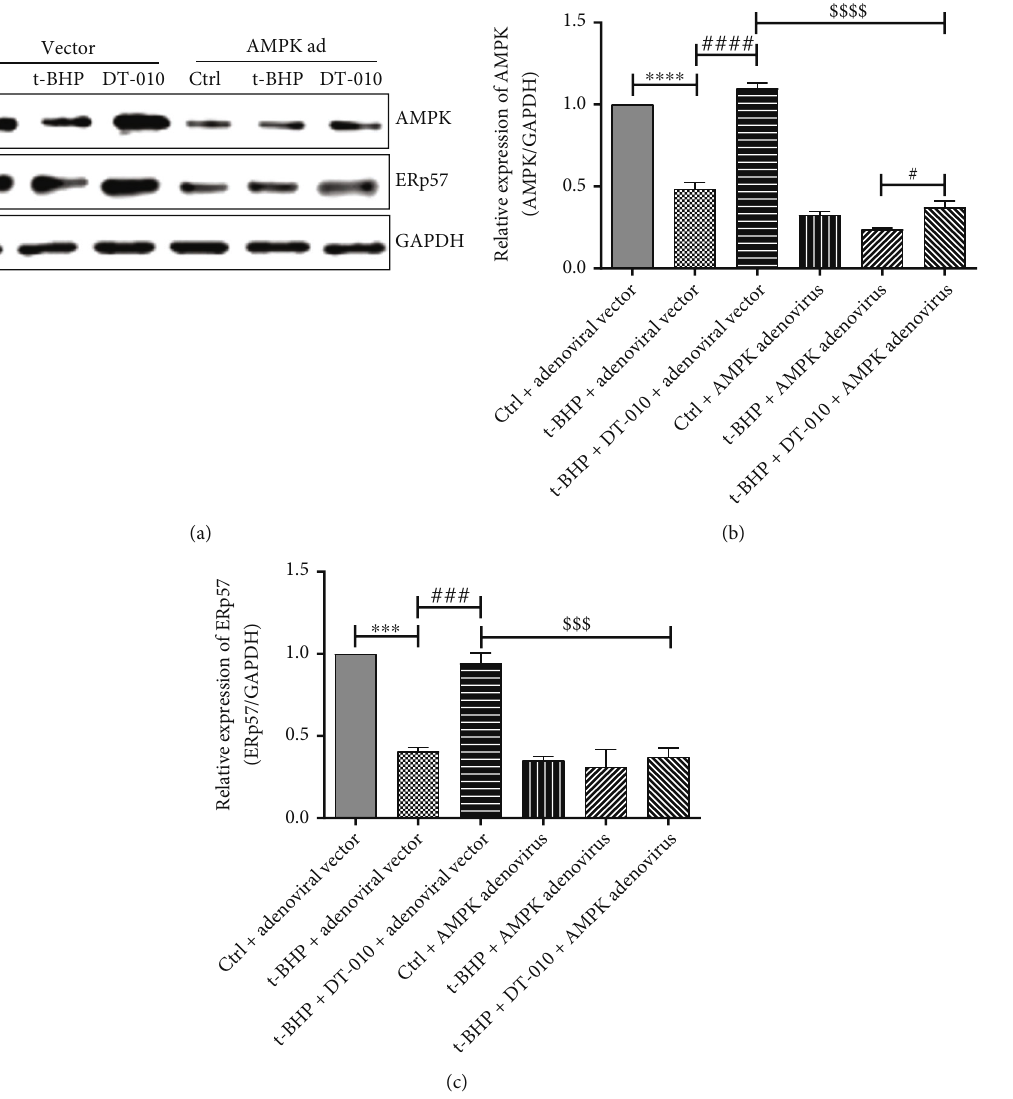
Figure 4: Adenovirus-mediated knockdown of AMPK abolished the upregulation of DT-010 on ERp57 protein expression in H9c2 cells. (a) Representative Western blot of AMPK and ERp57. (b, c) Quanti fi cation of Western blot band density of AMPK (b) and ERp57 (c). Data are mean ± SD of two independent experiments. ∗∗∗ P < 0 : 001 and ∗∗∗∗ P < 0 : 0001 ; # P < 0 : 05 , ### P < 0 : 001 , and #### P < 0 : 0001 ; $$$ P < 0 : 001